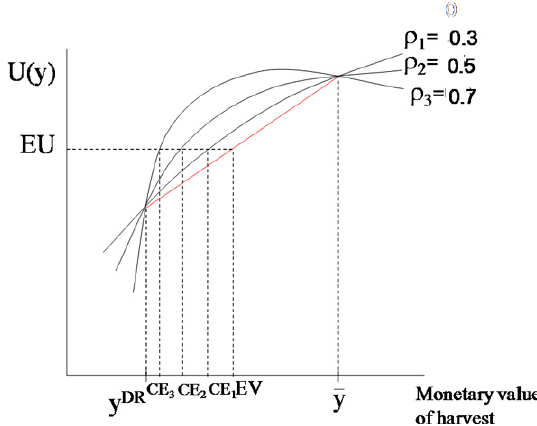
Fig. 3. Expected value (EV), expected utility (EU) and certain equivalent (CE) and sensitivity analysis to risk